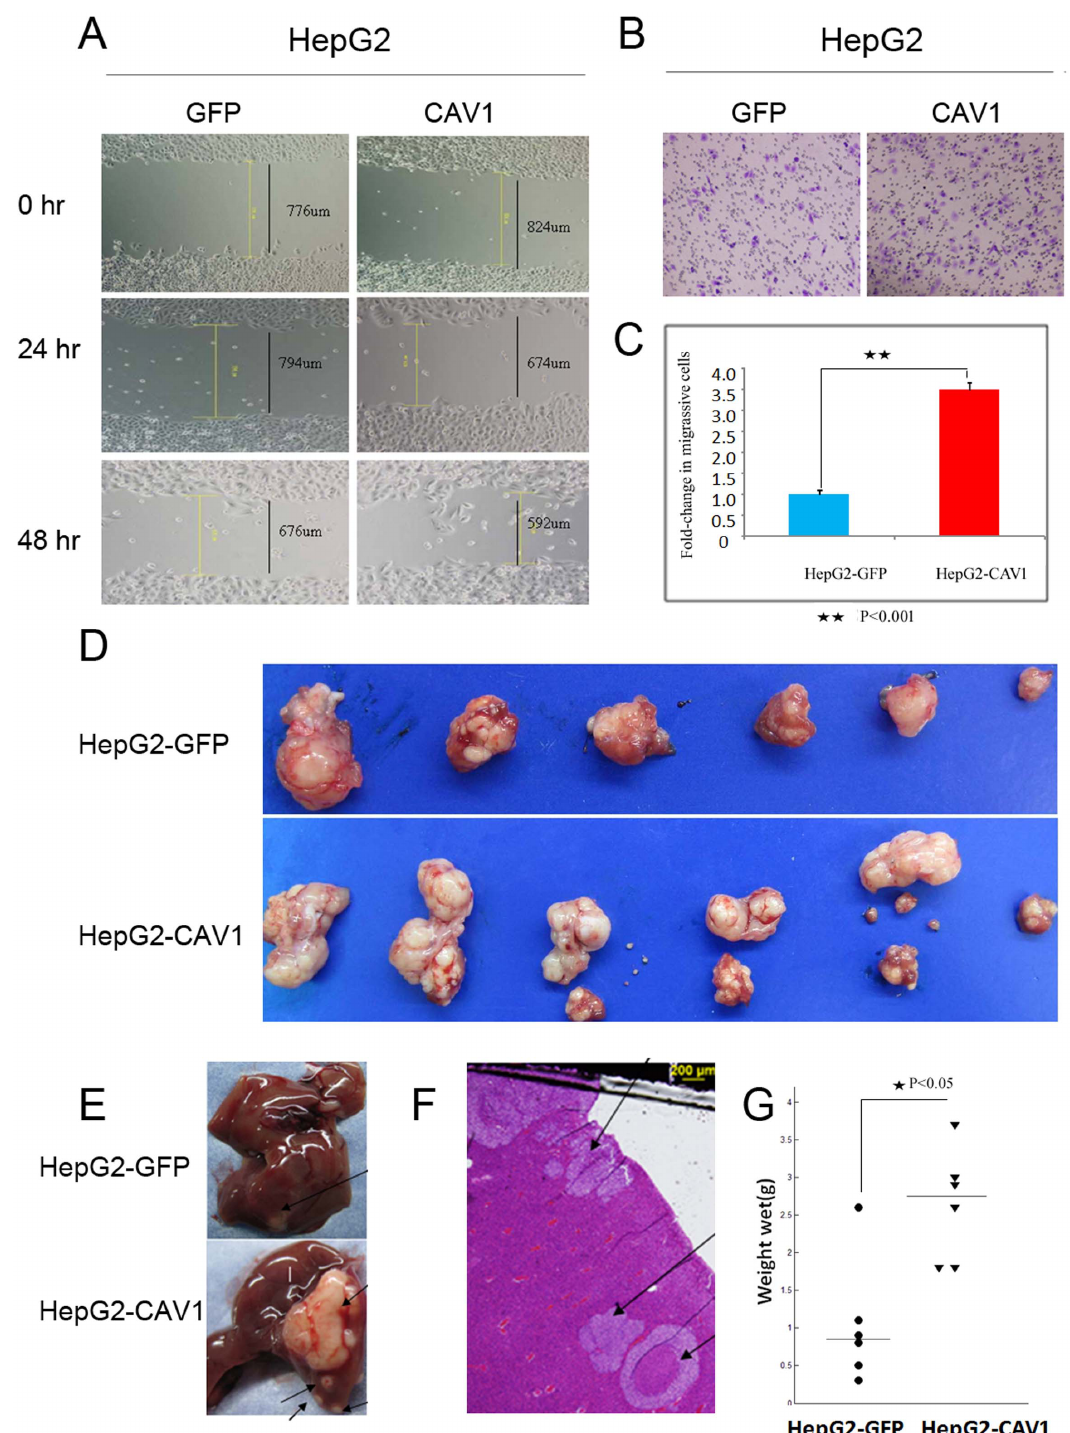
Figure 2. CAV1 modulates HCC cell migration, growth, and metastasis. A, CAV1 overexpression promotes cell migration in HepG2 cells that express GFP and CAV1 using a wound-healing assay. B, Transwell migration assay of HepG2 cell, viewed at 6 200 and stained with purple for three independent experiments. C, Comparison analysis with data as mean 6 SD , and the statistically significant differences with Student’s t-test. D and E, Effect of CAV1 overexpression on the HepG2 cell metastasis using letivirus–CAV1 via orthotopic implantation. Locoregional metastases, classified as abdominal wall metastases and intrahepatic metastases (black arrow) were observed by day 40. F, representative images show intrahepatic metastases (black arrow) and H&E-stained sections. G, The quantification of average weight of xenograft tumors at 6 weeks is shown. * P , 0.05.